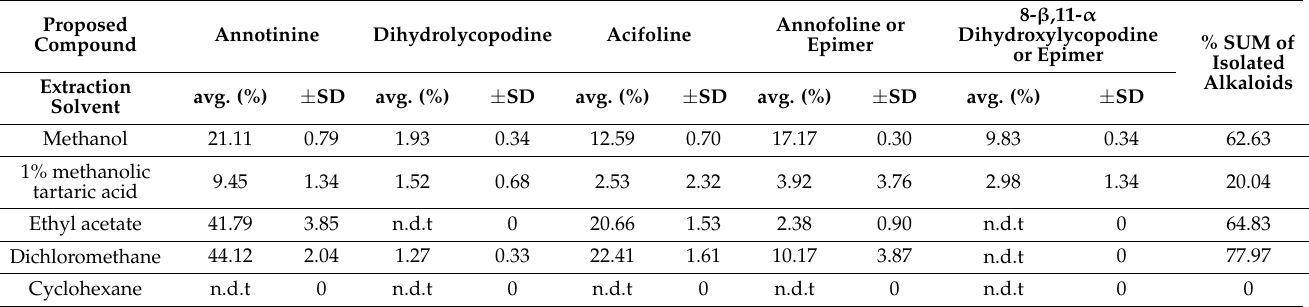
Table 2. PLE of Lycopodium annotinum L. using five kind of solvents systems (Section 3.2) and purified by SPE procedure (Section 3.3). The obtained extracts were identified by HPLC/ESI-QTOF (Section 3.4) and the five main alkaloids were isolated with different